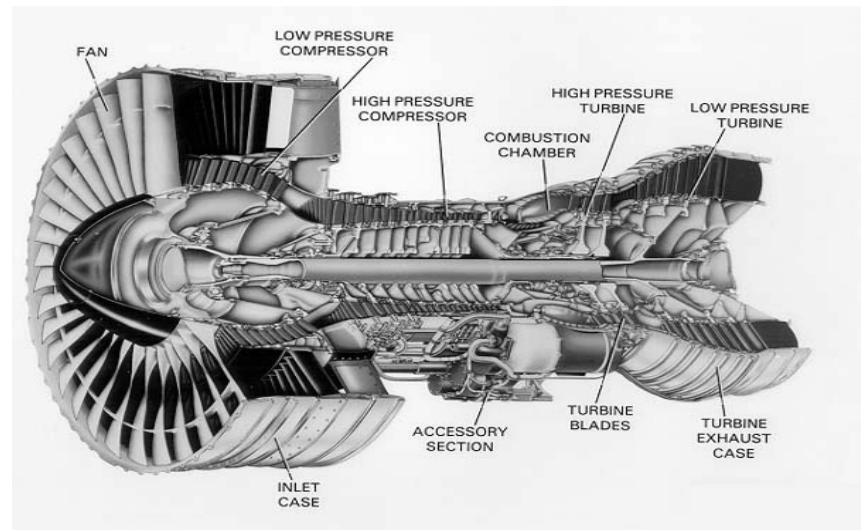
Fig. 1. A typical turbofan jet